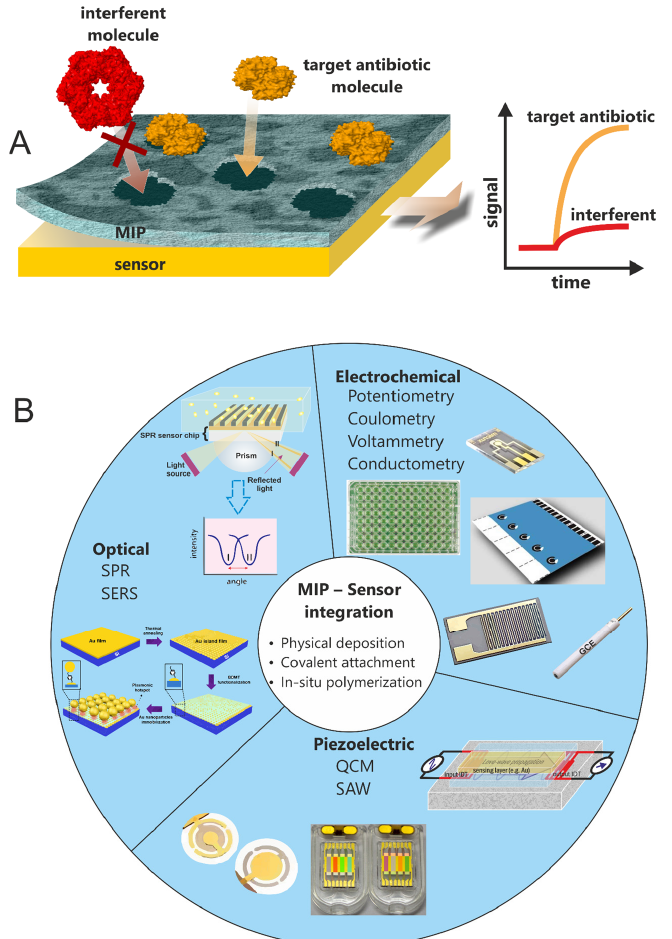
Figure 3. ( A ) Schematic illustration of the label-free detection by a MIP layer integrated with the sensor surface, ( B ) types and examples of label-free sensors commonly employed in MIP research. SERS example is reproduced with permission from Springer Nature (doi.org/10.1038/s41598-021- 01742-0).